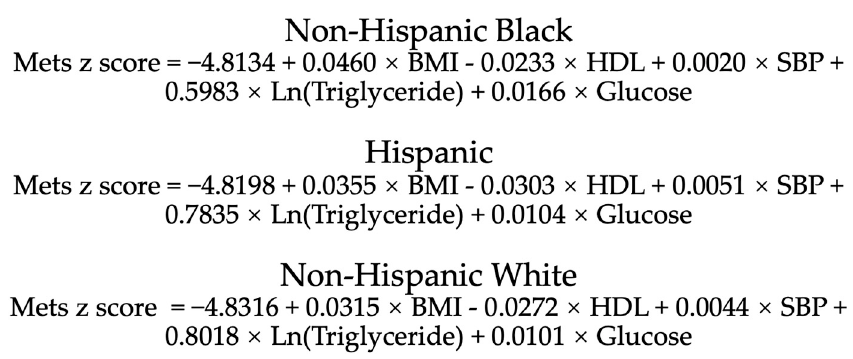
Figure 1. Calculation formula of MetS BMI z-score for male of different races. BMI, body mass index; HDL, high density lipoprotein; SBP, systolic blood pressure. BMI: kg/m 2 ; HDL, triglyceride, glucose: mg/dl; SBP: mmHg.